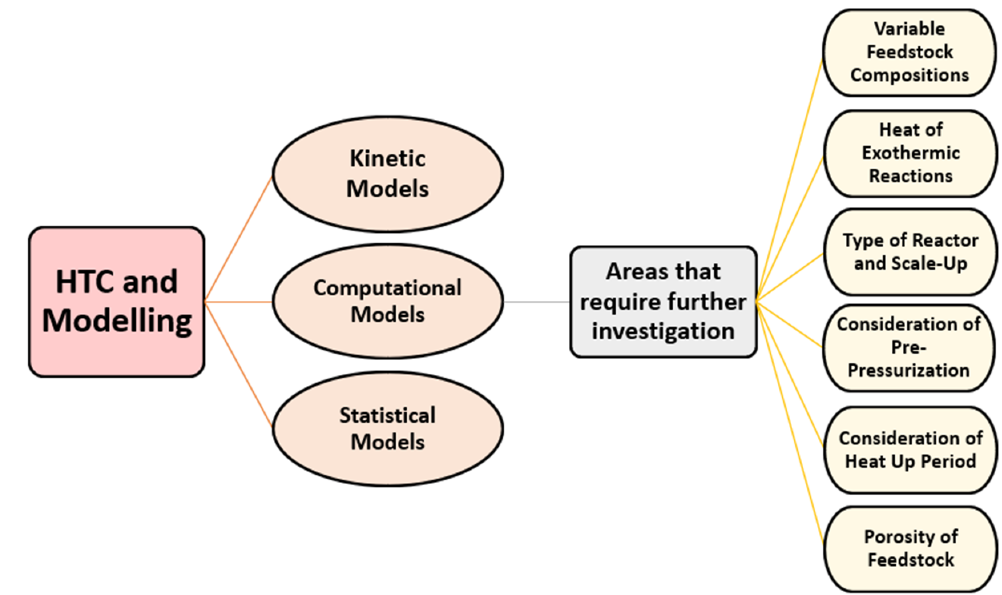
Figure 1. Areas that require further investigation for computational models.